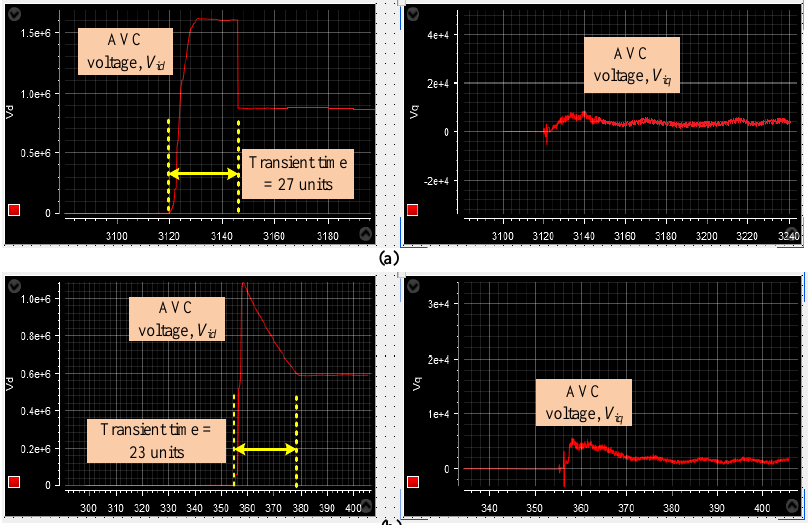
Figure 16. AVC voltages captured from dSPACE control desk (a) using conventional SVPWM (b) using UVSVPWM.